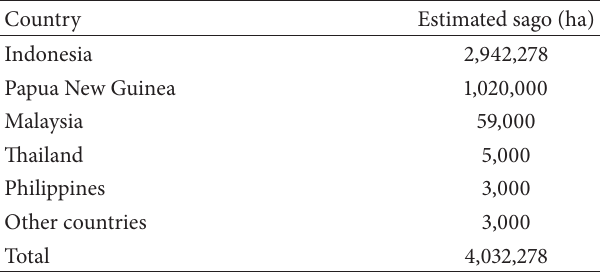
Table 1: Estimated sago hectarage by countries.